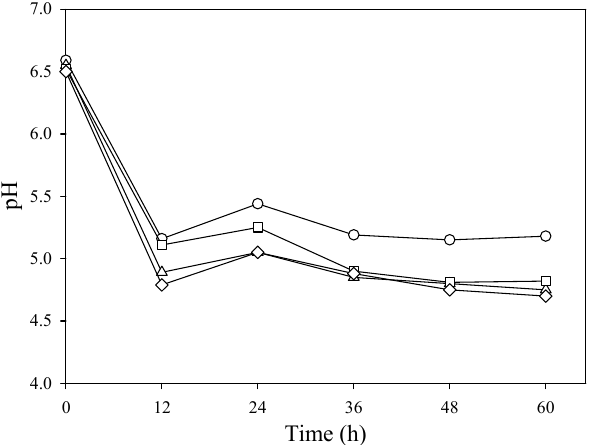
Figure 6. The pH profiles during butanol fermentations from SSJ medium containing 0.64 g/L of urea and various buffers with C. beijerinckii TISTR 1461. Buffer A ( ○ ): KH 2 PO 4 , K 2 HPO 4 , and ammonium acetate; buffer B (□): KH 2 PO 4 and K 2 HPO 4; buffer C (∆): ammonium acetate; no buffer (◊).